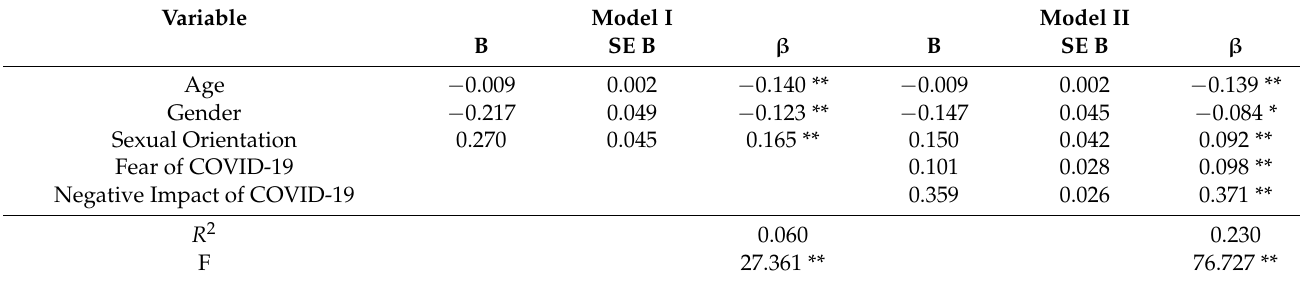
Table 9. Hierarchical linear regression analysis predicting Depressive